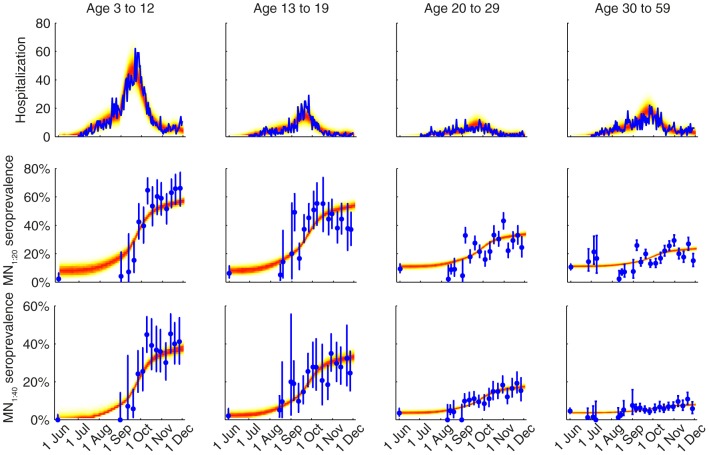
Comparison of the data and the fitted model.The hospitalization and serial cross-sectional seroprevalence data are shown in blue (vertical bars indicate 95% confidence intervals). Posterior intervals of hospitalizations and seroprevalence in the fitted model are shown as heat shades in which darker colors represent higher probability densities (i.e. highest density in red and zero density in white).